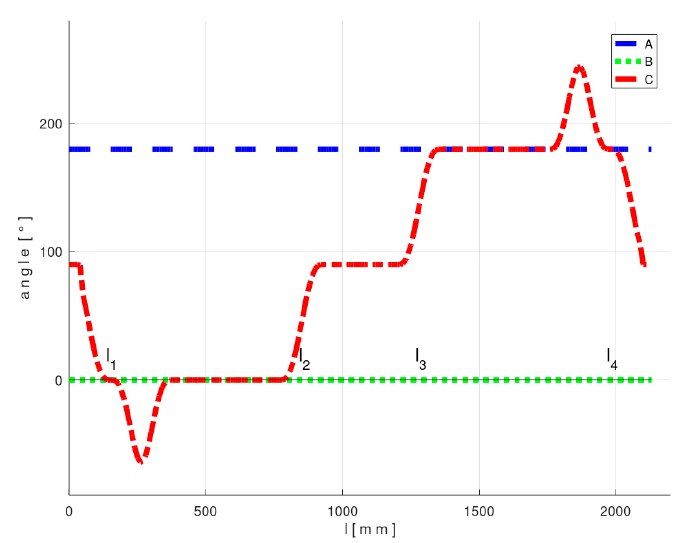
Figure 20. Test 1—Diagram of the optimal course of the TCP OPT during the passage of the frame through the fiber-processing head - values of the last three parameters of optimal TCP OPT .